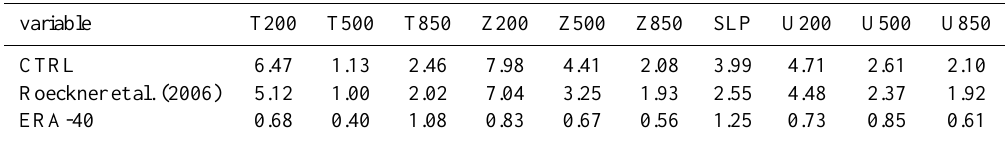
Table 1. RMSEs with respect to ERA-40 (1979–1993) for temperature T (in °C), geopotential height Z (in dam), and zonal wind U (in ms − 1 ) at pressure levels 200, 500, and 850hPa, and sea level pressure SLP (in hPa). RMSEs in Roeckner et al. (2006) are for ECHAM5 in T42L19 (same resolution as used here) with respect to ERA-15. The rms differences between ERA-15 and ERA-40 are taken from Table 2 (Roeckner et al., 2006). variable